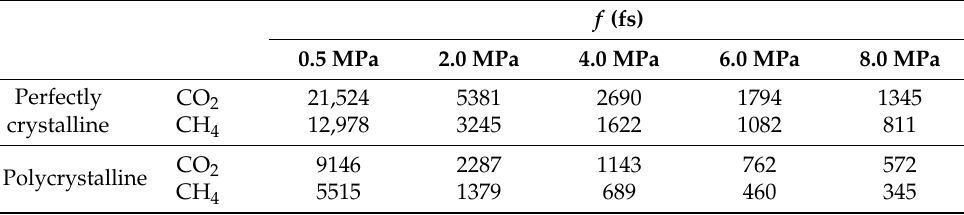
Table 1. Calculations of the time interval f for generating a gas molecule on each membrane